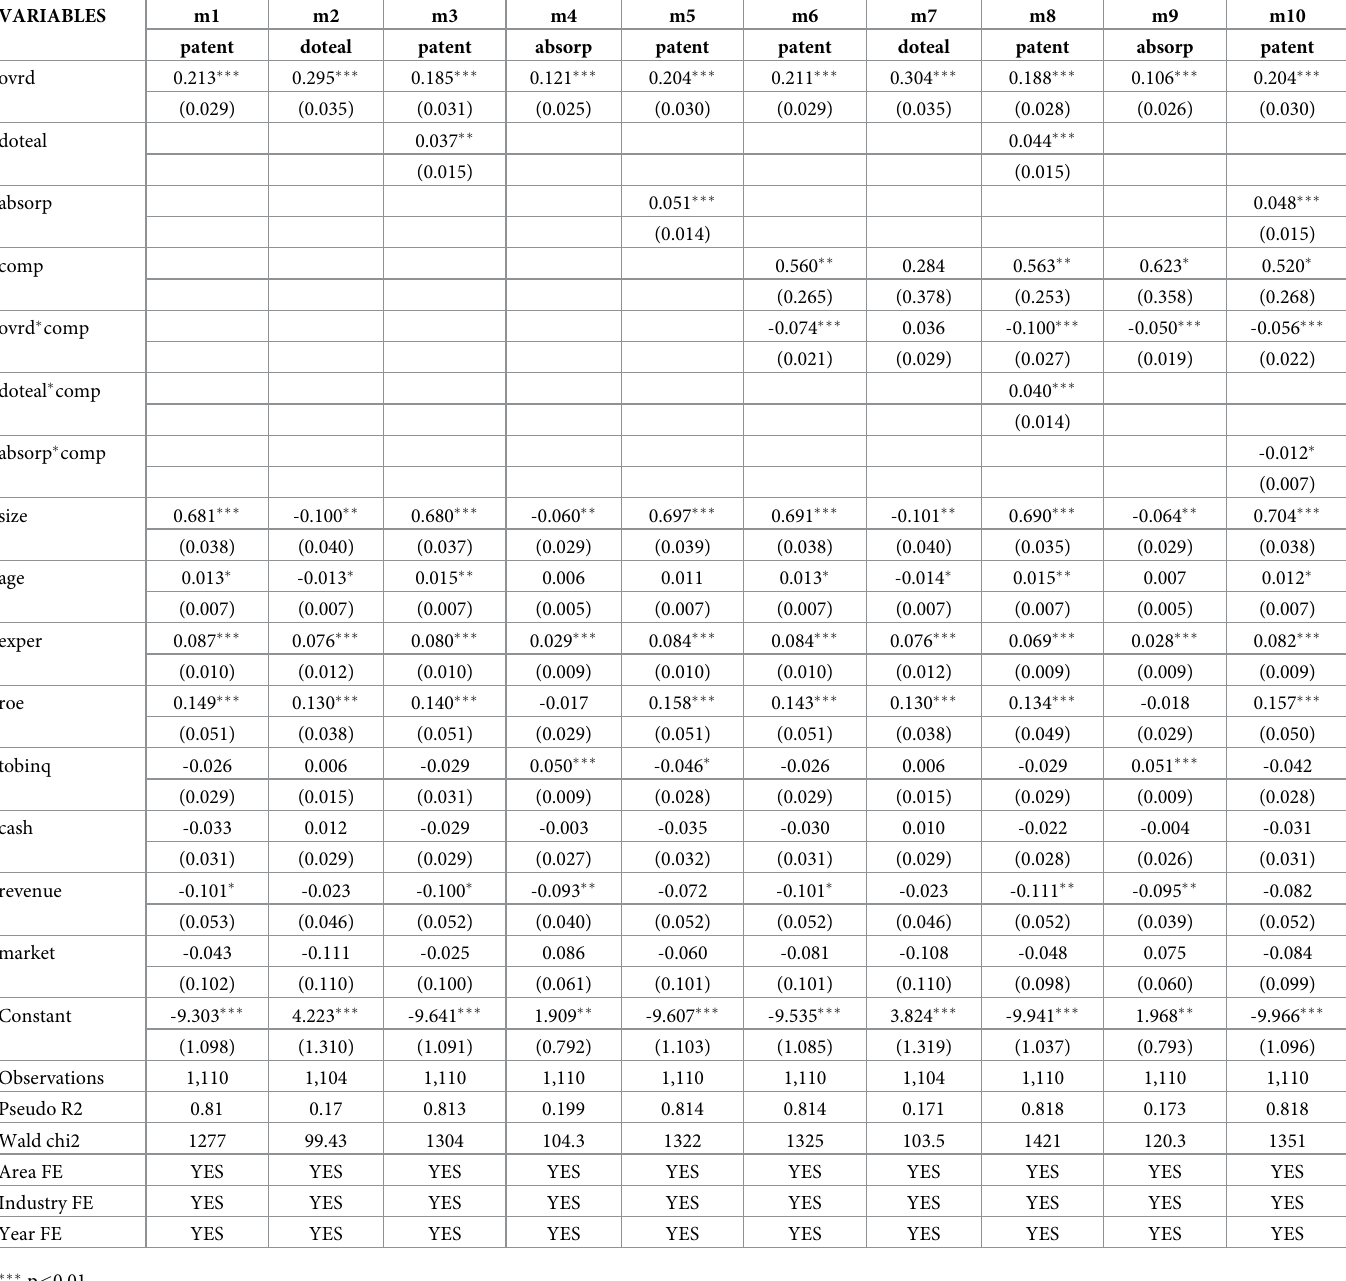
Table 5. Regression results of